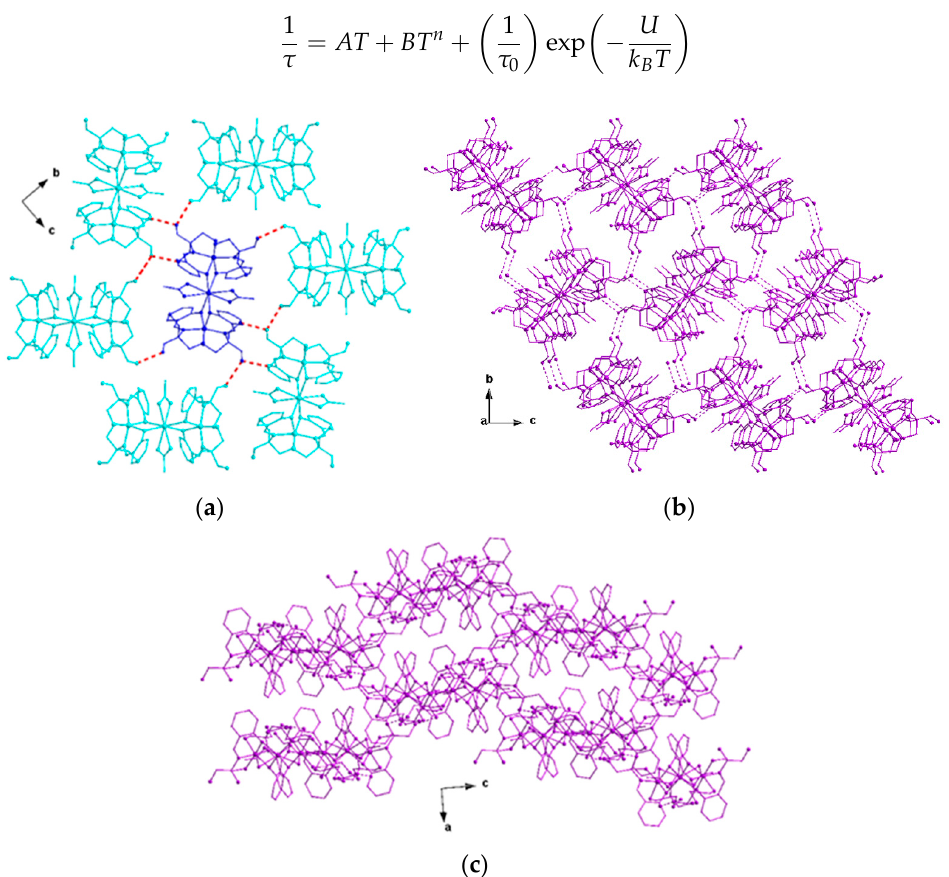
Figure 3. ( a ) The 6-connected node in 1 with hydrogen bonds shown as red dashed lines. ( b ) A small part of the 3D supramolecular network of 1 in the bc plane, ( c ) in the ac plane.